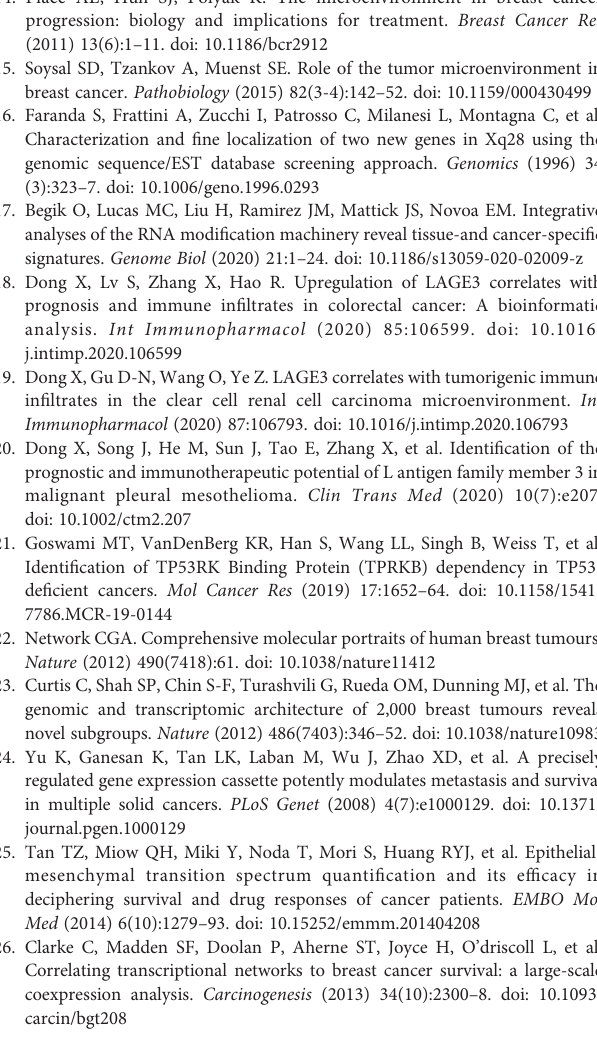
SUPPLEMENTARY TABLE 1 | Clinical and pathological features of patients in TCGA and METABRIC cohort. SUPPLEMENTARY FIGURE 1 | Correlation of LAGE3 expression with clinicopathological characteristics in local BC patients. (A, B) LAGE3 expression in the (A) different tumor sizes and (B) stage subgroups in the TCGA dataset. SUPPLEMENTARY FIGURE 2 | Expression pro fi le of LAGE3 in TNBC tissues and normal breast tissues. (A) The LAGE3 transcript levels in TNBC and adjacent normal breast tissues from the GSE76250 cohort. (B) LAGE3 expression in local TNBC tissues and paired normal breast samples as determined by qRT –